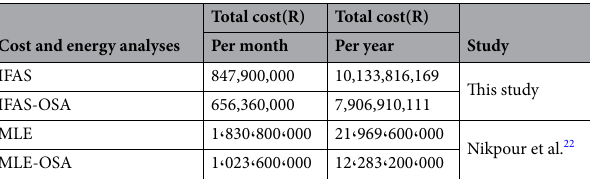
Table 9. Comparison of cost and energy analyses of the present study with other